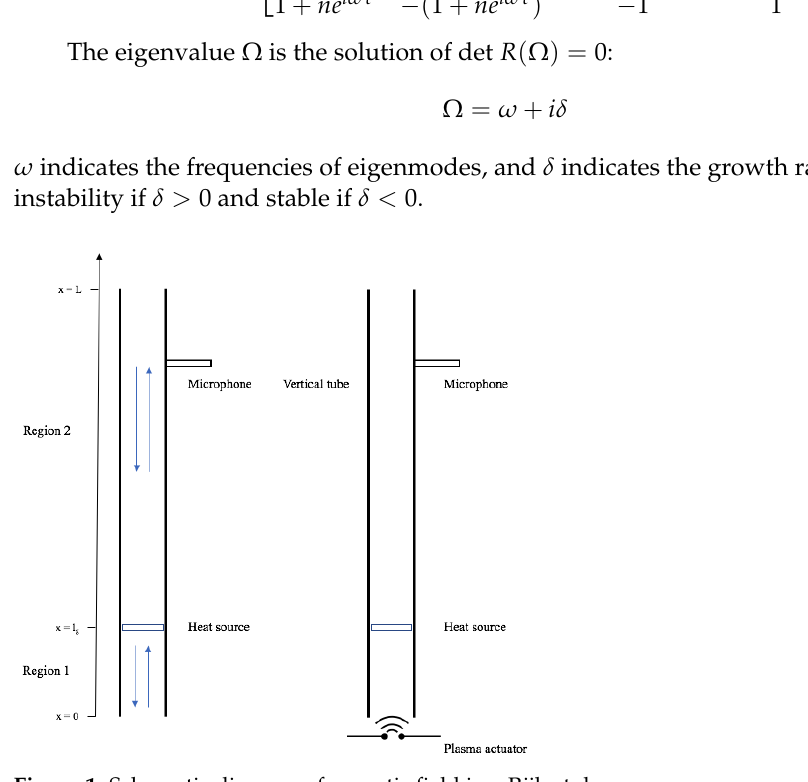
Figure 1. Schematic diagram of acoustic field in a Rijke